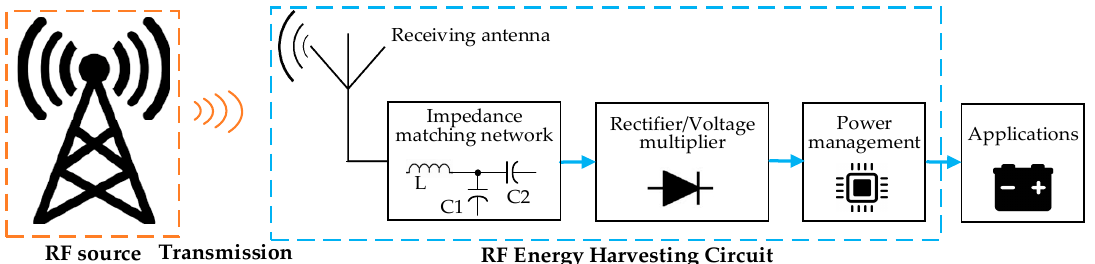
Figure 7. Structure of RF energy harvesters.